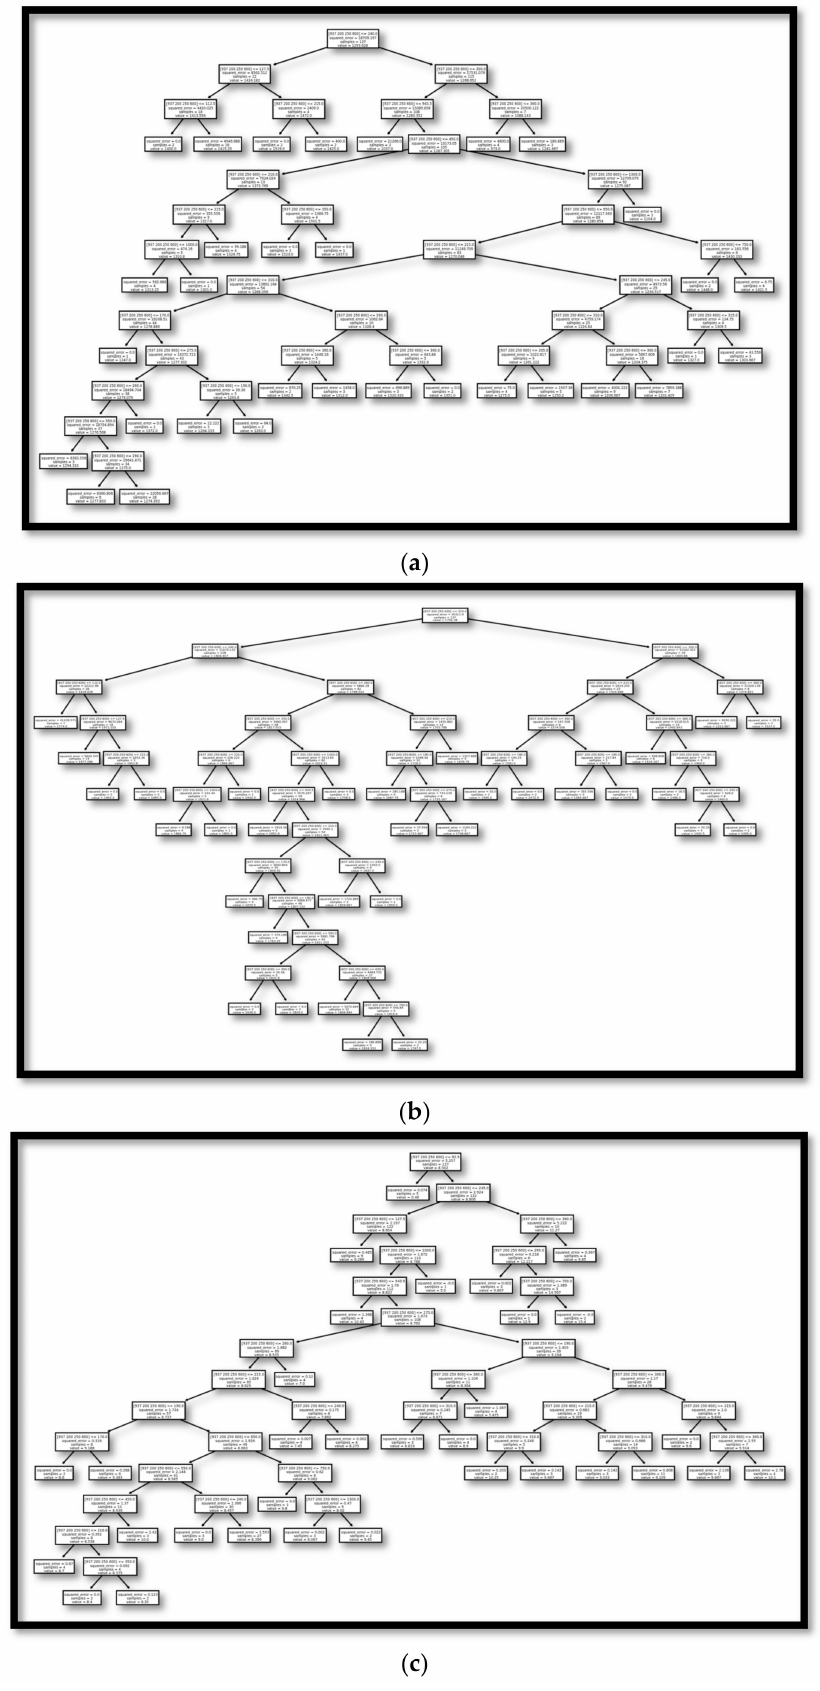
Figure 9. The applications of Decision Tree Regression in modelling R.02 ( a ), Rm ( b ), and A20 ( c